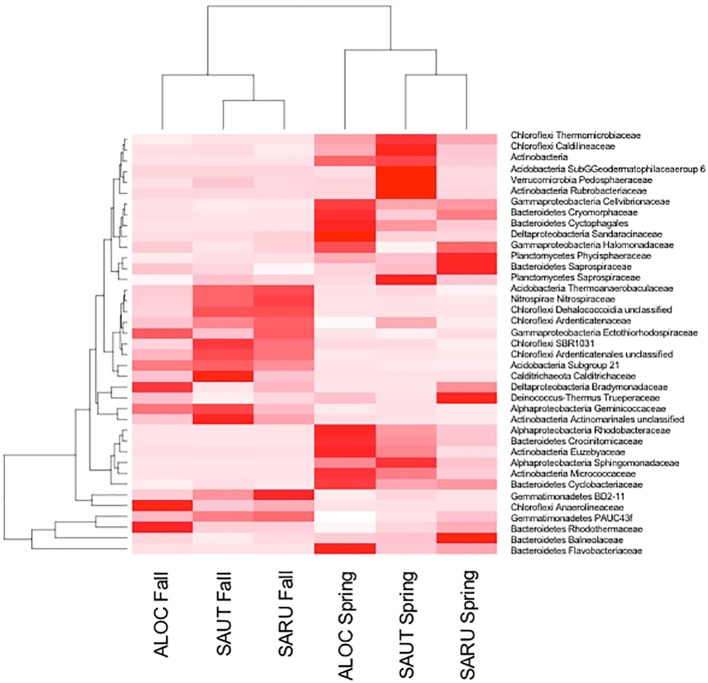
Rhizosphere bacteria of the three halophytes in spring and fall samplings. Heat map and dendrogram showing relationships between the abundance of major bacterial families and samples collected in the fall and in the spring. ALOC, Allenrolfea occidentalis; SAUT, Sarcocornia utahensis; SARU, Salicornia rubra.